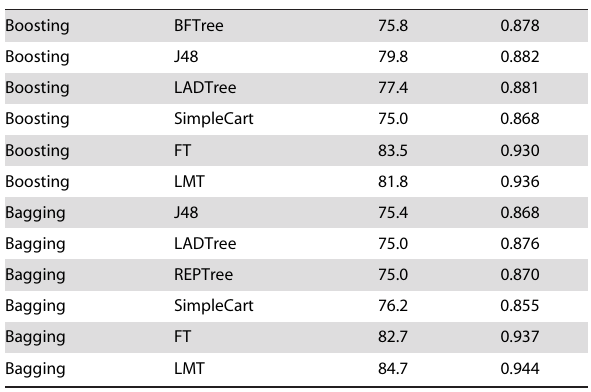
Ensemble method Tree-based algorithm Accuracy (%) ROC area